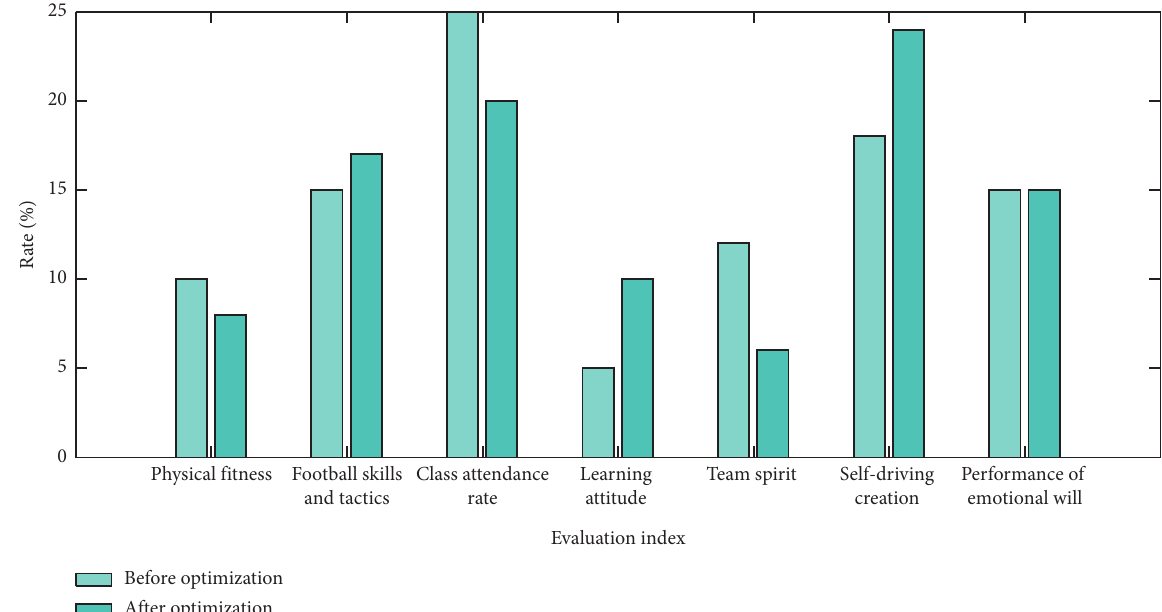
Figure 7: The proportion of teachers’ evaluation of students’ academic performance after the optimization of the football professional teacher’s teaching evaluation